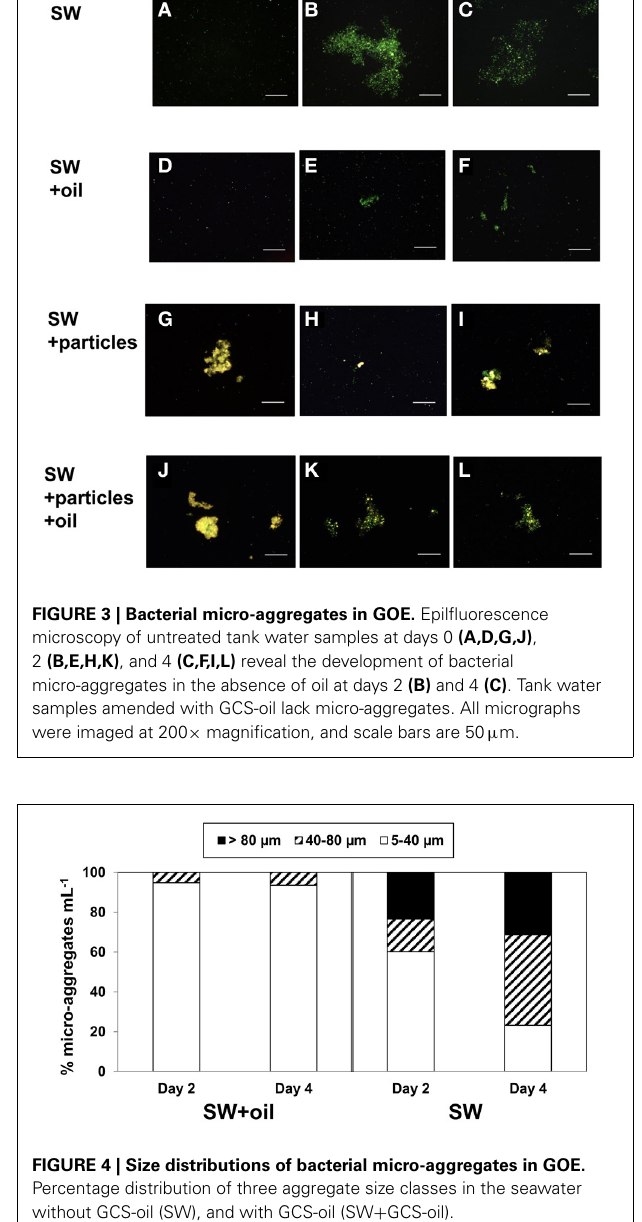
the lack of oil snow formation, the addition of GCS-oil to sur- face water triggered a specific bacterial metabolic response that affected the timescales of bacterial cycling of carbon in our roller tank